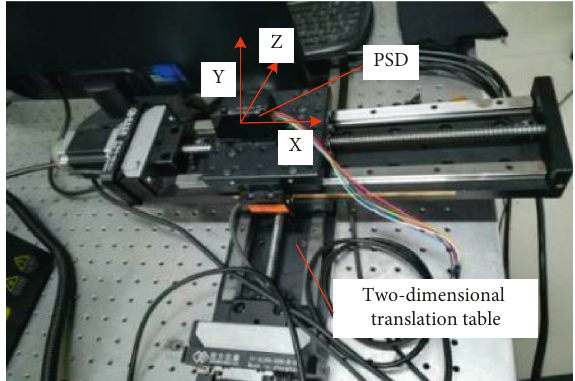
Figure 11: PSD and two-dimensional translation table.